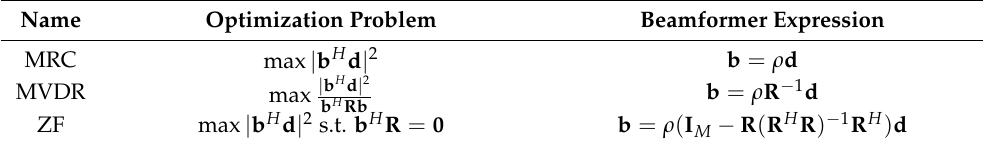
Table 1. Summary of main beamforming